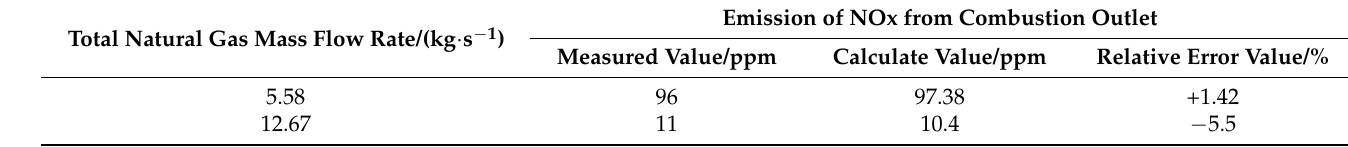
Table 3. Comparison of multi-combustion emission data with simulation results.